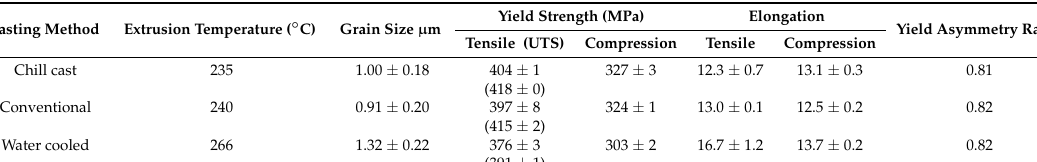
Table 2. Extrusion temperature, grain size, yield strength, ultimate tensile strength (UTS) and elongation to failure in tension and compression, and the yield symmetry ratio corresponding to each casting method.